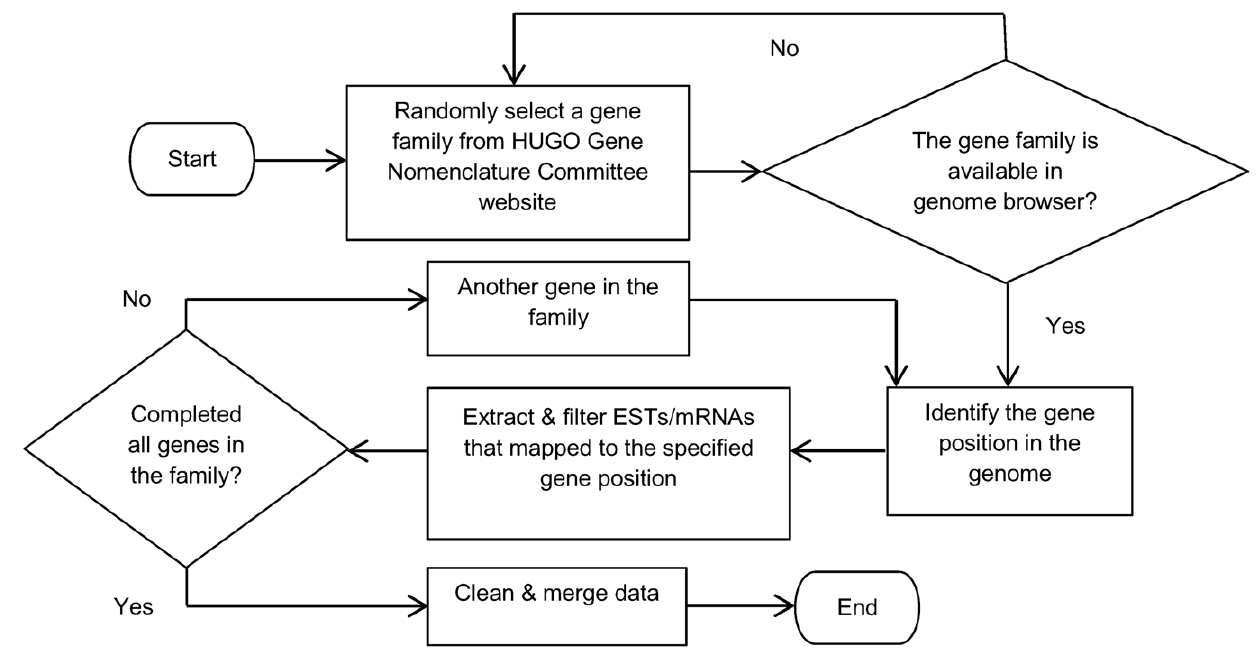
Figure 5. The flow chart diagram for the extraction of EST datasets using the Genome Browser.